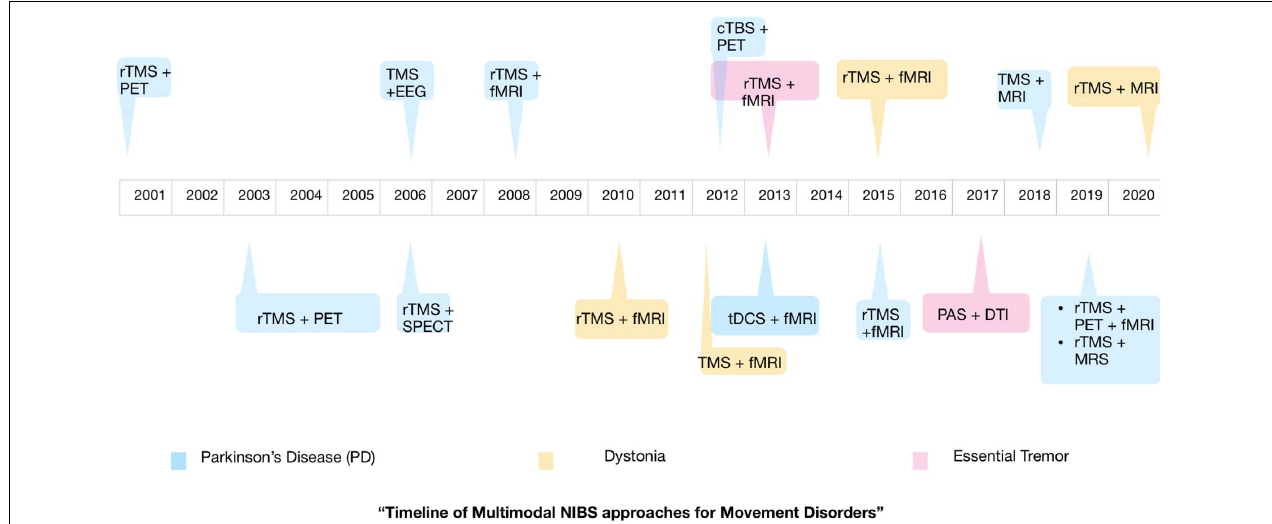
FIGURE 2 | Timeline showing the publication of multimodal non-invasive brain stimulation (NIBS) studies investigating movement disorders. Parkinson’s disease is the most studied movement disorder using multimodal NIBS. The majority of studies used a combination of repetitive TMS and MRI.